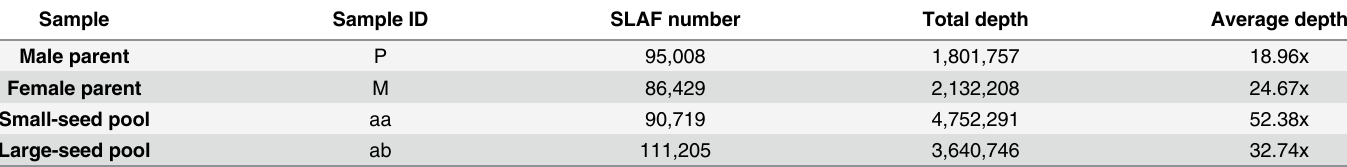
Table 2. Statistic results of SLAF tags for both parents and bulked DNA